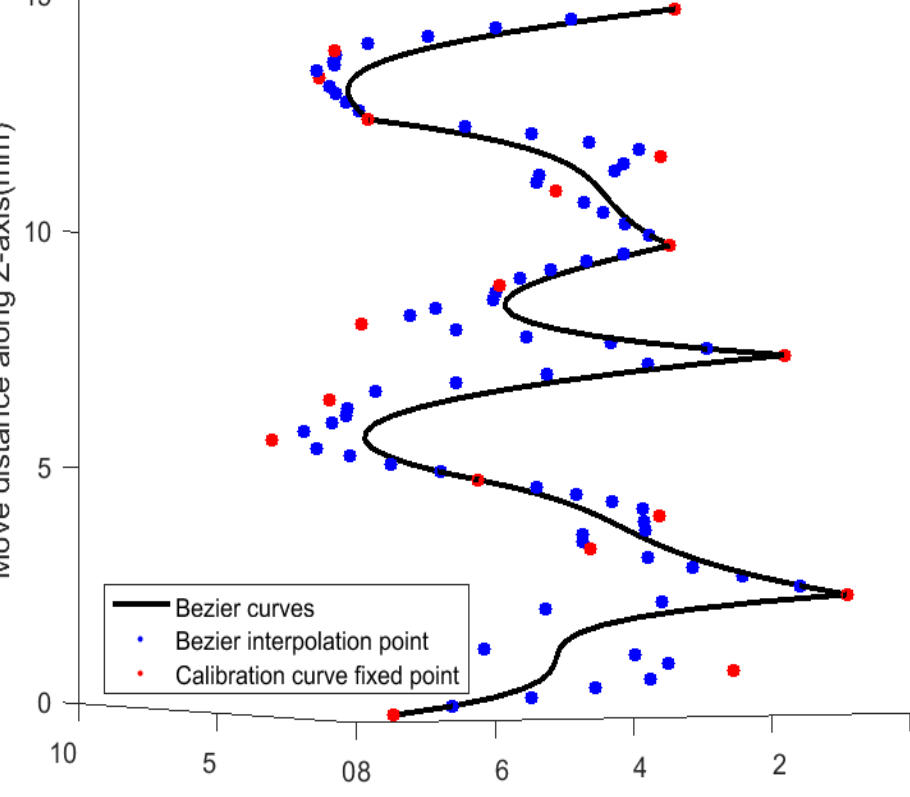
Figure 13. Bezier interpolation curve of dataset DB1.